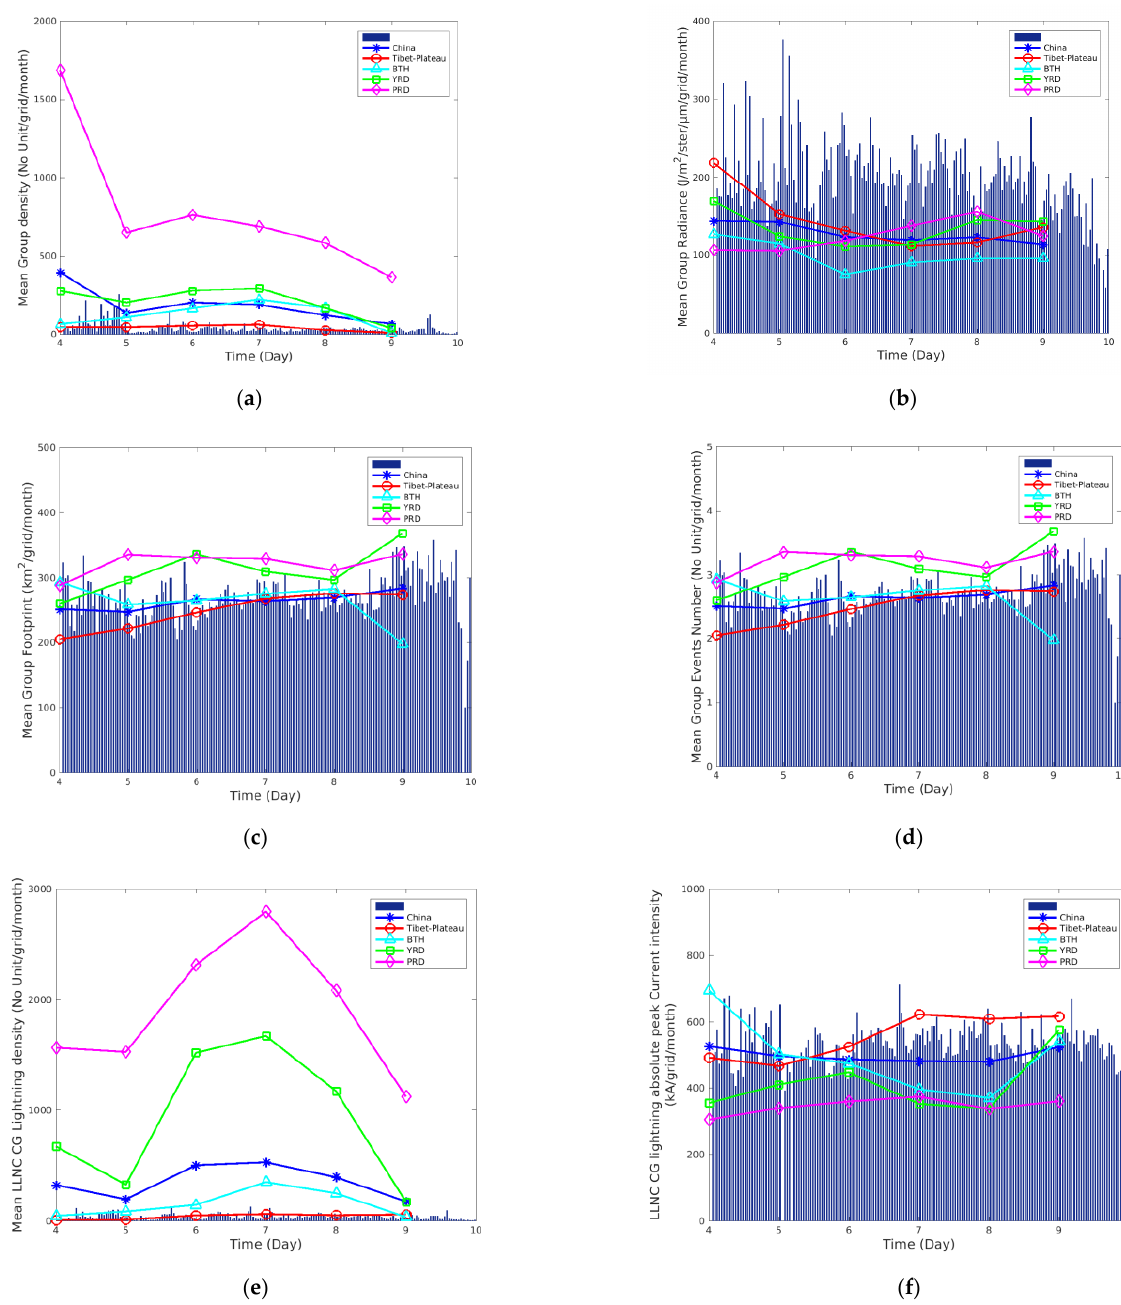
( e ) Figure 9. Temporal variation in the LMI Flashes in four typical regions in China. ( a ) Flash density, ( b ) Radiance, ( c ) Dura- tion, ( d ) Footprint, and ( e ) Flash-Groups number. The bar chart indicates daily variation, and the line chart indicates monthly variation.